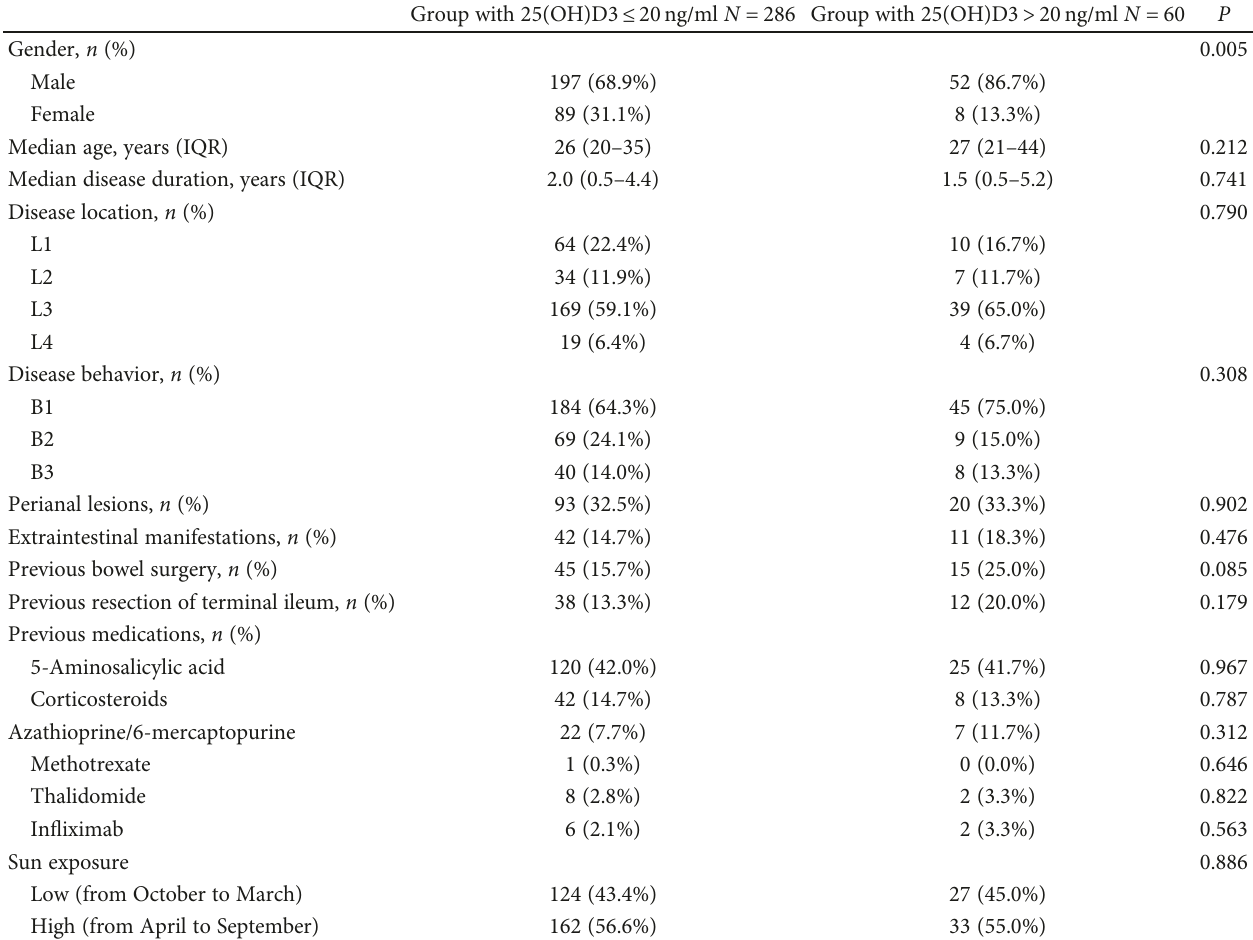
Table 1: Demographic and clinical